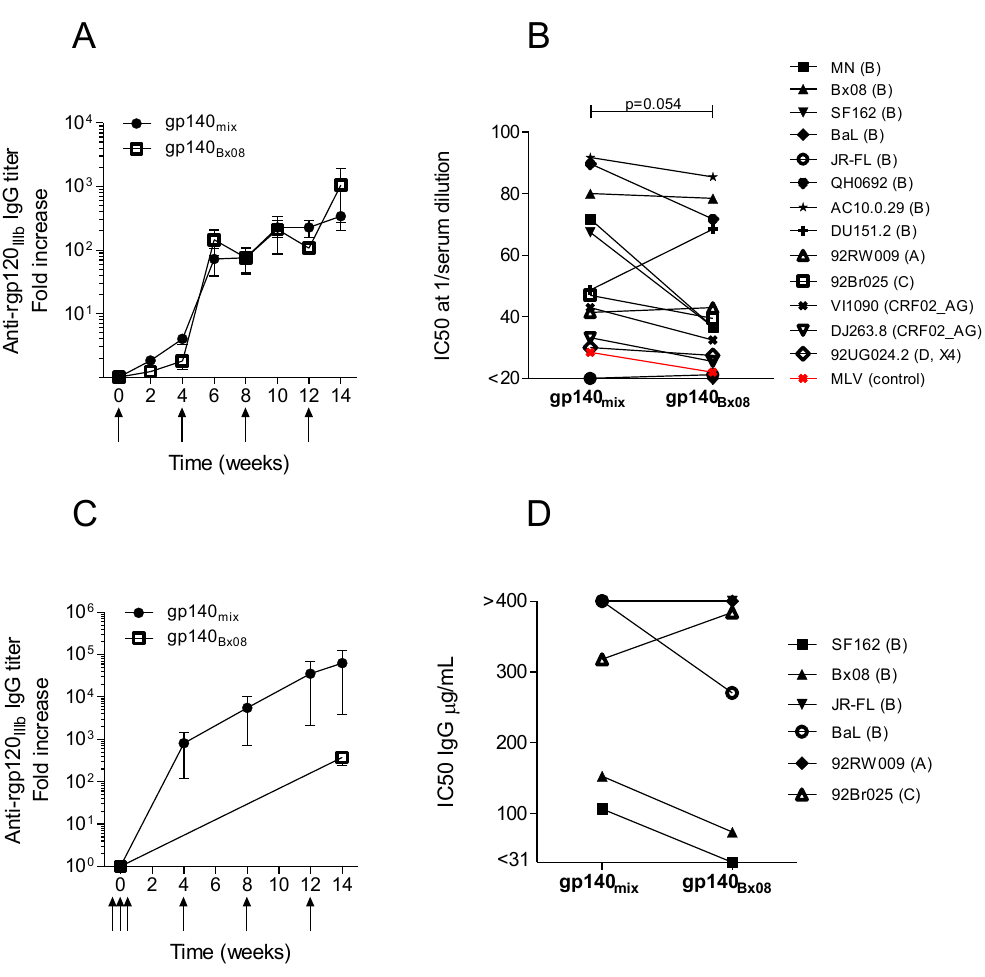
Figure 2. Comparison of the immune responses in animals vaccinated with monovalent or trivalent DNA. Average IgG responses against rgp120 (n = 4) and ( C ) rabbits (n = 4). Immunization time points are indicated with arrows. Average neutralizing activity, expressed as IC50, of diluted guinea pig serum ( B ) or purified rabbit IgG ( D ) from week 14 against pseudotype virus strains of clade A–D and CRF02_AG. Unrelated MLV pseudotype virus was included as non-specific HIV control in the guinea pig setup (red). IgG titers ( C ) and IC50 values ( D ) from syn.gp140 derived from Figure